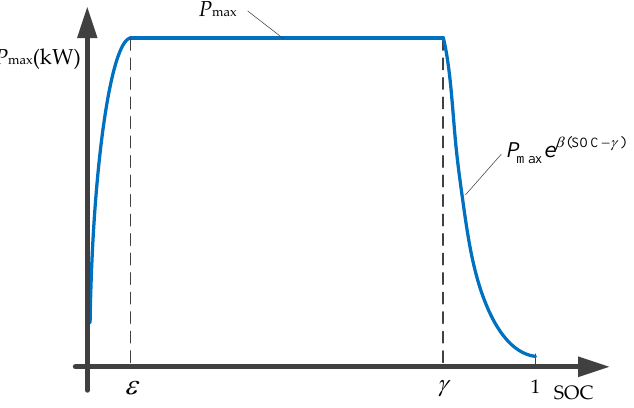
Figure 2. Maximum charging power of battery at different state of charge.